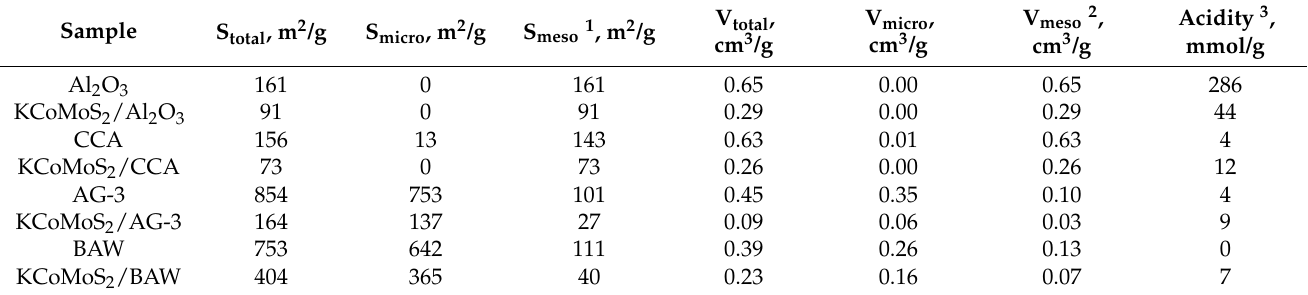
Table 2. Textural characteristics and acidity of supports and